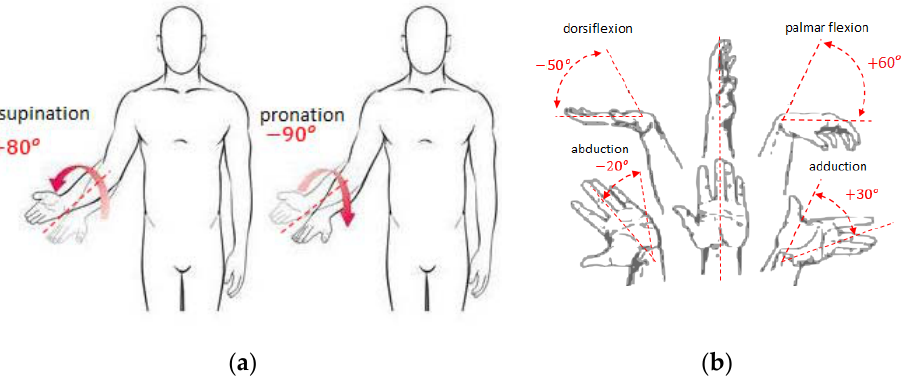
Figure 3. Supported movements of the upper limb with ranges of motion (RoM): ( a ) forearm pronation and supination; ( b ) palmar/dorsiflexion and adduction/abduction of the hand.